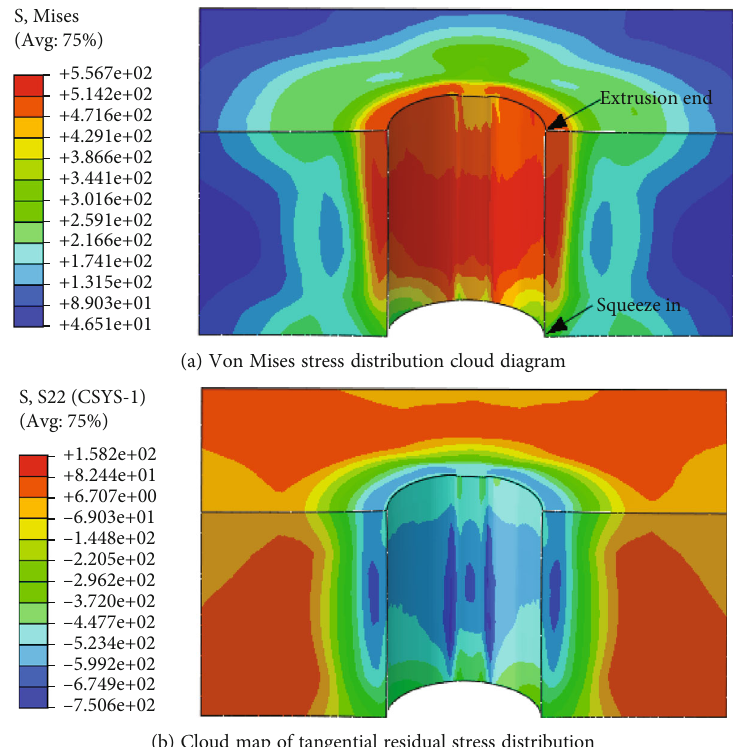
Figure 6: Von Mises stress cloud diagram and tangential residual stress cloud diagram.